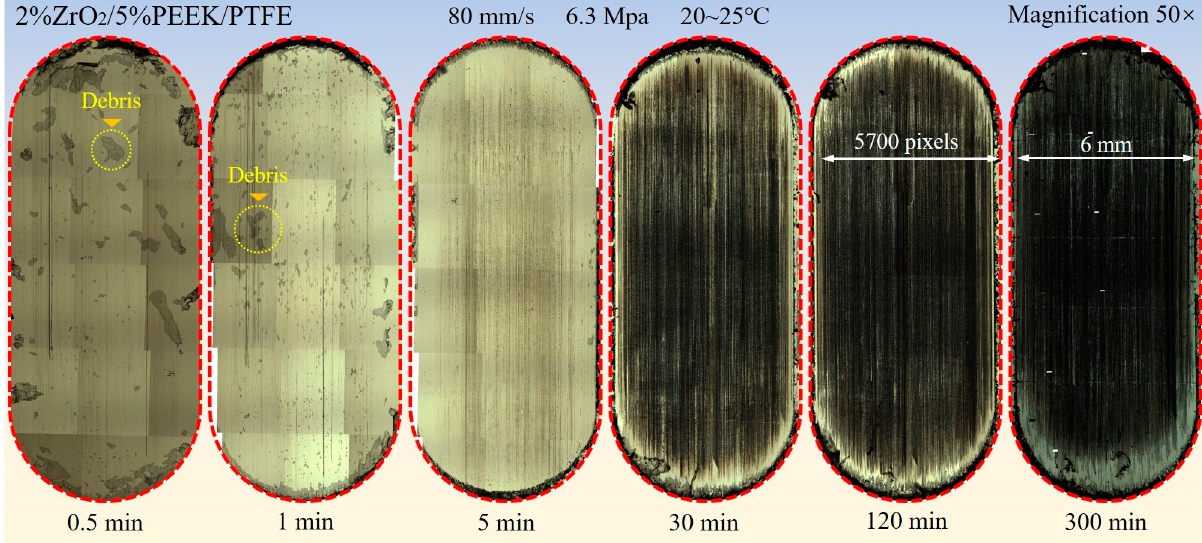
Figure 2. Synthetic image of the friction areas on the surface of the counterpart metal at different stages of friction.